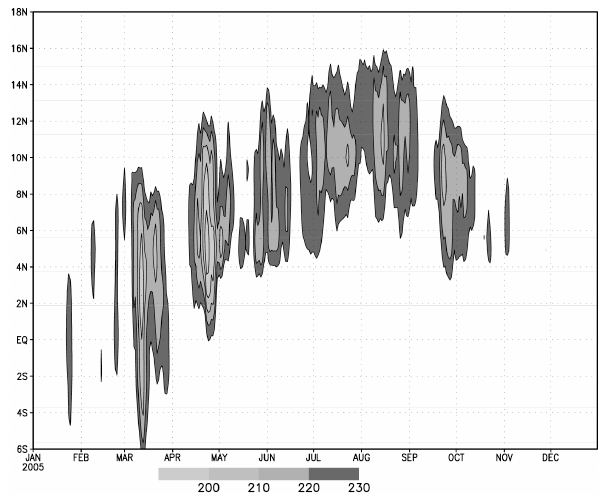
Figure 13. Same as Fig.6 but for 2005 Fig. 13. Same as Fig. 6 but for